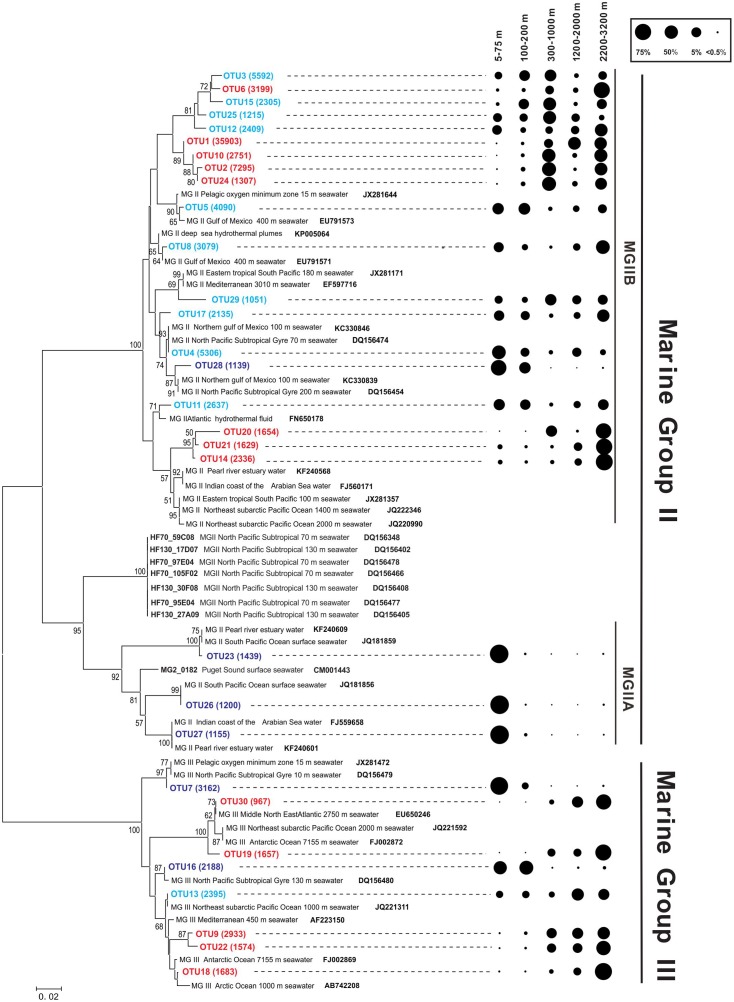
Phylogenetic tree based on the 16S rRNA gene from the Northeastern SCS (A: B7 and D5 stations). Support values, with 1000 replicates for Neighbor-Joining (NJ) analyses, were shown in the order of NJ at nodes (values lower than 50% are not shown). The numbers of environmental sequences of top OTUs recovered in this study were shown in the brackets. Dark blue OTUs indicate sequences mainly distributed in the photic zone; red OTUs indicate sequences mainly distributed below the photic zone; and cyan OTUs indicate sequences distributed relatively evenly in the photic and aphotic zones. Reference sequences from NCBI database were shown in bold. The scale bar indicates 0.02 nucleotide substitutions per site. The distribution of the dominant OTUs of MGII and MGIII is shown at right, where the circle size indicates the relative abundance of sequences in each OTU at different depth intervals.